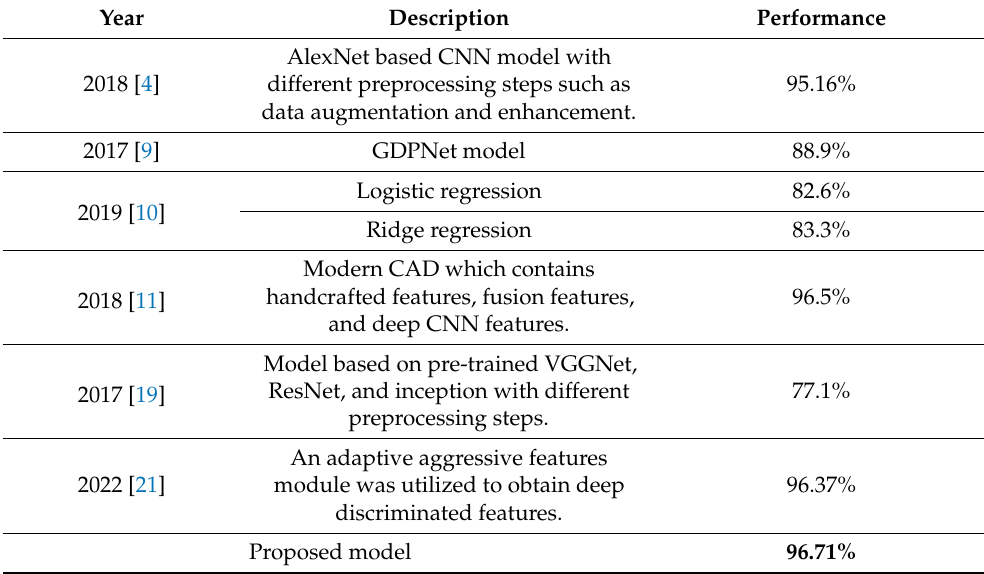
Table 9. Comparison of proposed technique with state-of-the-art techniques.